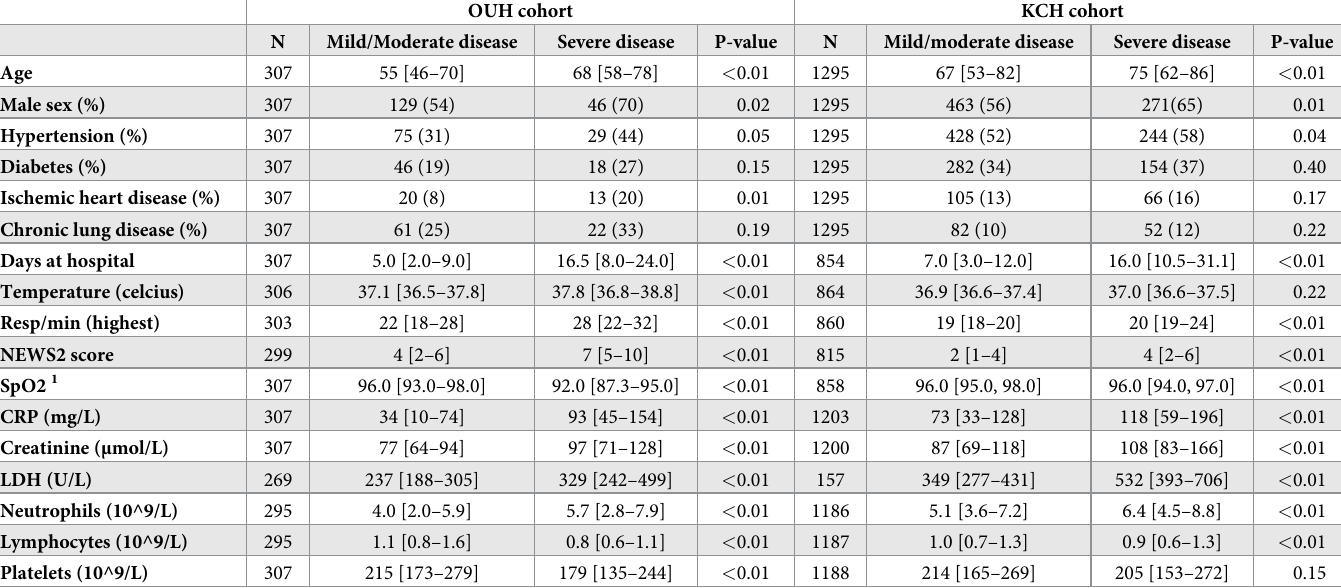
Table 3. Univariate analysis of predictors in mild/moderate and severe